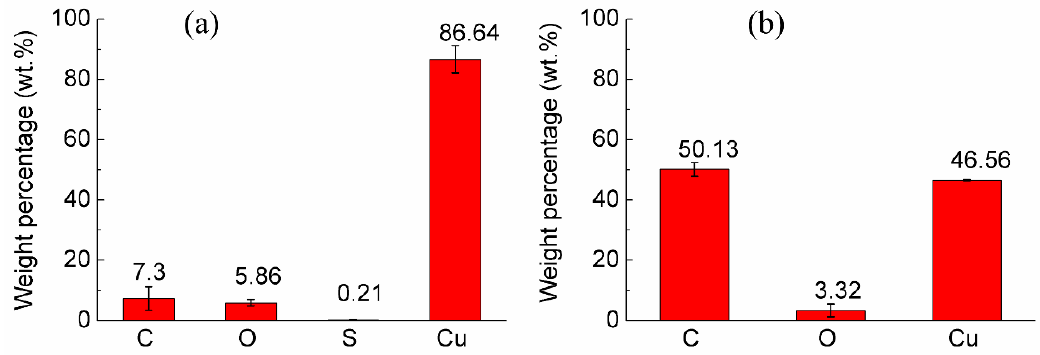
Figure 7. The weight percentages of coatings in each specimen: ( a ) Specimen A, and ( b ) specimen B.